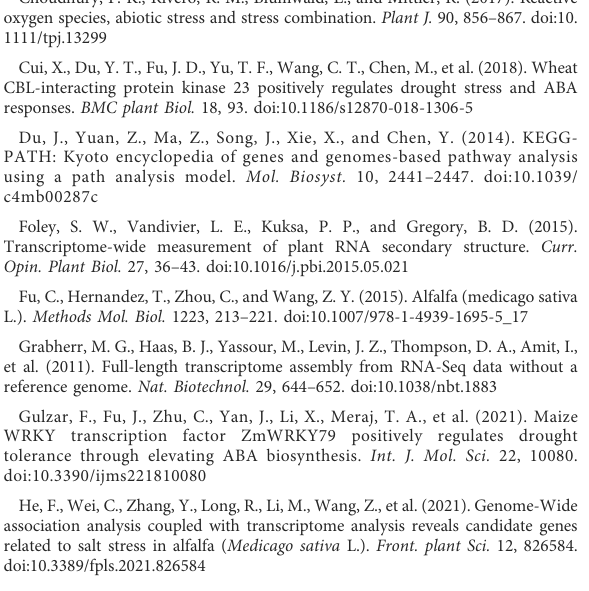
SUPPLEMENTARY FIGURE S1 The data information of full-length transcriptome. (A) FLNC